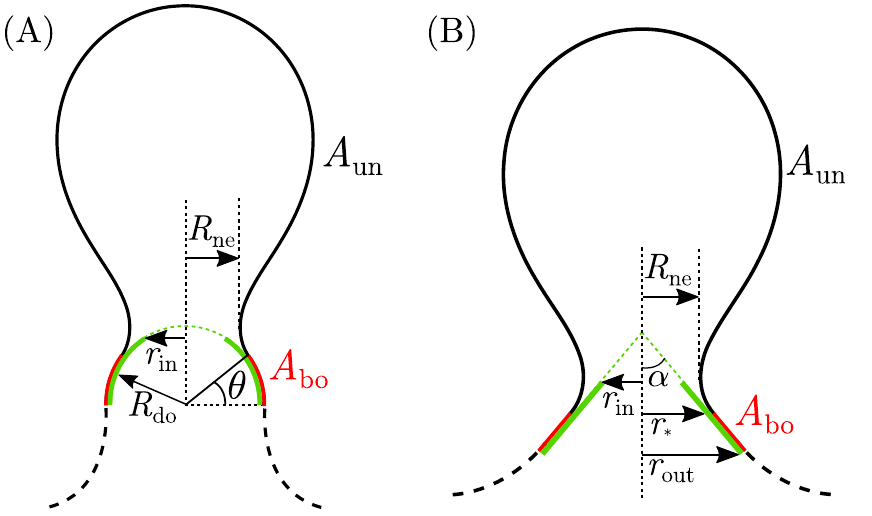
Fig 2. Geometry of dome-shaped and cone-shaped membrane–protein complexes. (A) The dome model, with dome radius R do and inner radius r in ; and (B) the truncated cone model, with cone apex angle α , inner radius r in and outer radius r out . Both geometries are axisymmetric. The protein complex is represented by the solid green lines, while the dashed green lines are auxiliary lines representing the underlying spherical or conical shape of the complex. The unbound part of the membrane corresponding to the nascent bud (solid black segment, with area A un ) with neck radius R ne meets the part of the membrane bound to the protein (red segment, with area A bo ) along the contact line. The position of the contact line is described (A) by the attachment angle θ in the dome model; and (B) by the attachment radius r (cid:3) in the cone model. The unbound part of the membrane away from the bud (dashed black segment) detaches from the protein (A) at the equator of the hemispherical dome in the dome model; and (B) at the outer radius r out in the cone model. For low membrane tension, the shape of this unbound segment is catenoidal and does not contribute to the free energy of the system.